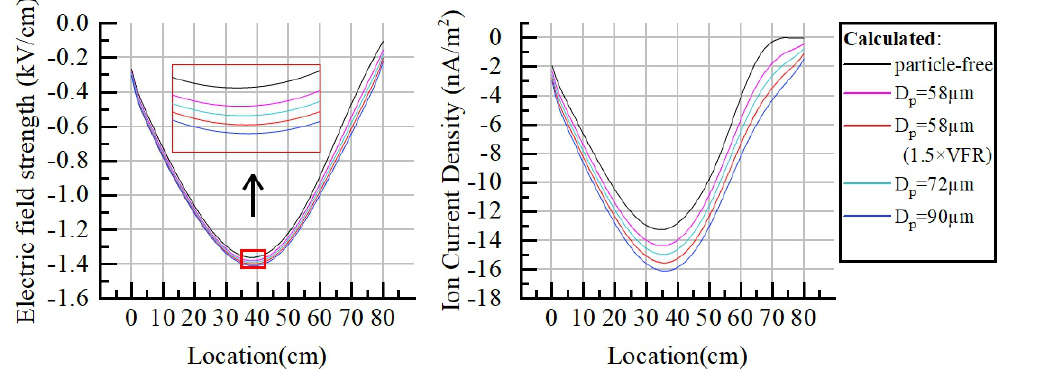
Figure 8. Calculated electric field intensity and ion current density under 15 m/s wind velocity.